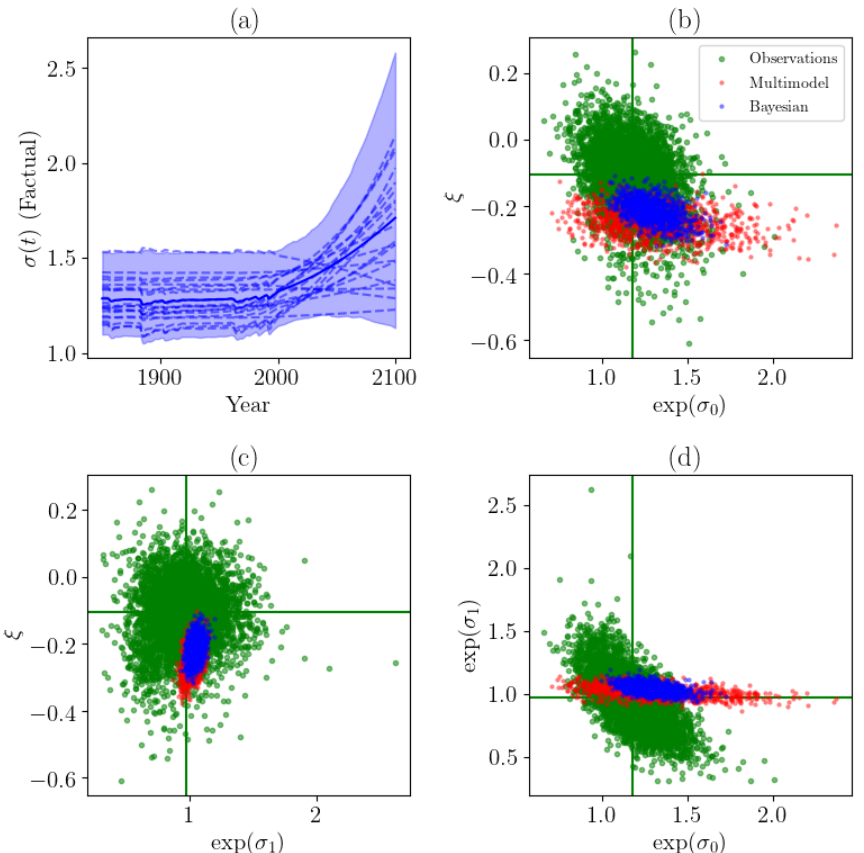
Figure 6. (a) Examples of the sample of σ ( t ) after the Bayesian constraint. (b) Stationary scale parameters versus shape parameters for multimodel synthesis (red), Bayesian constraint (blue) and from observations (green). (c) Same as (b) but between nonstationary scale parameters and shape parameters. (d) Same as (b) but between stationary and nonstationary scale